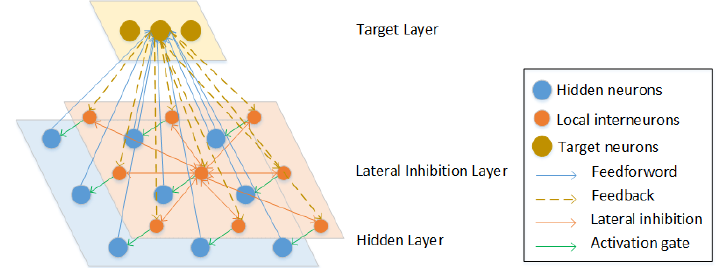
Figure 7. Lateral inhibition-inspired attention